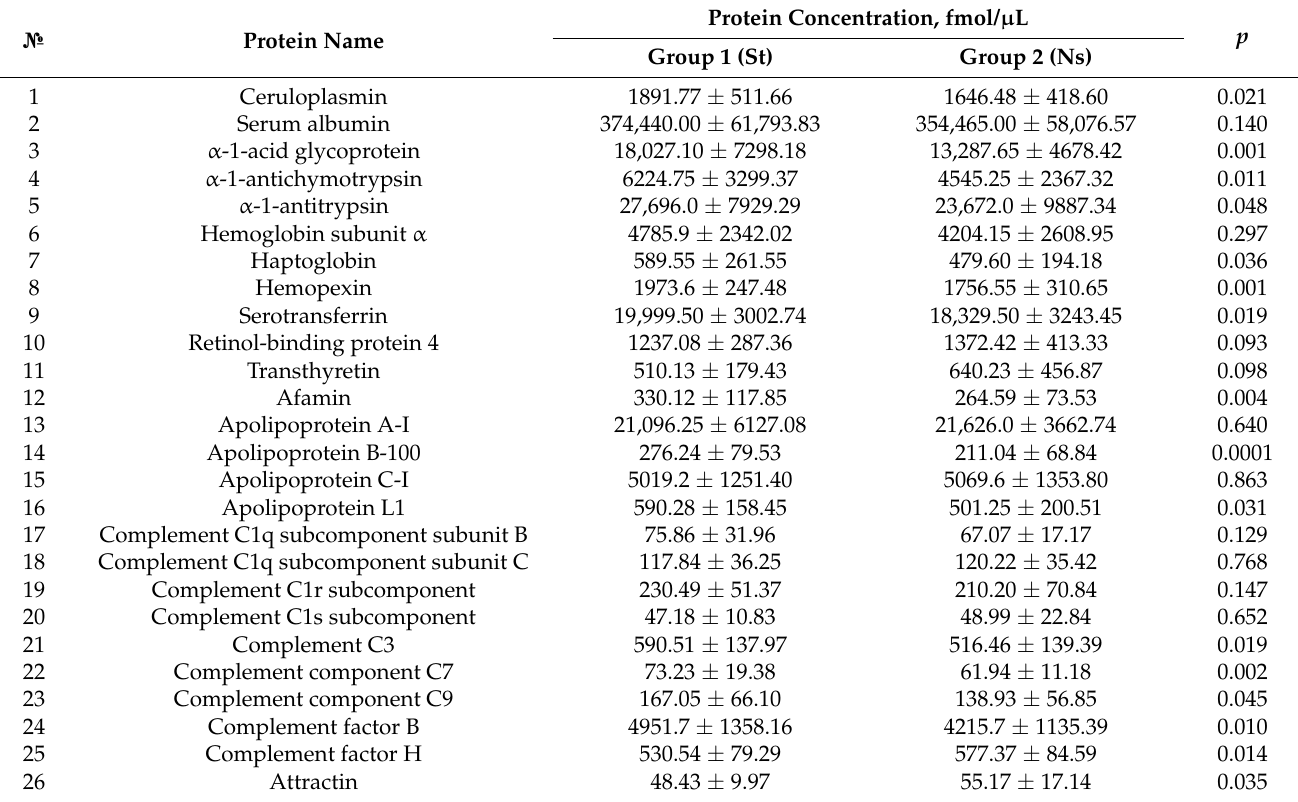
Table 1. Quantitative mass spectrometric identification of proteins in the blood (Mean ±